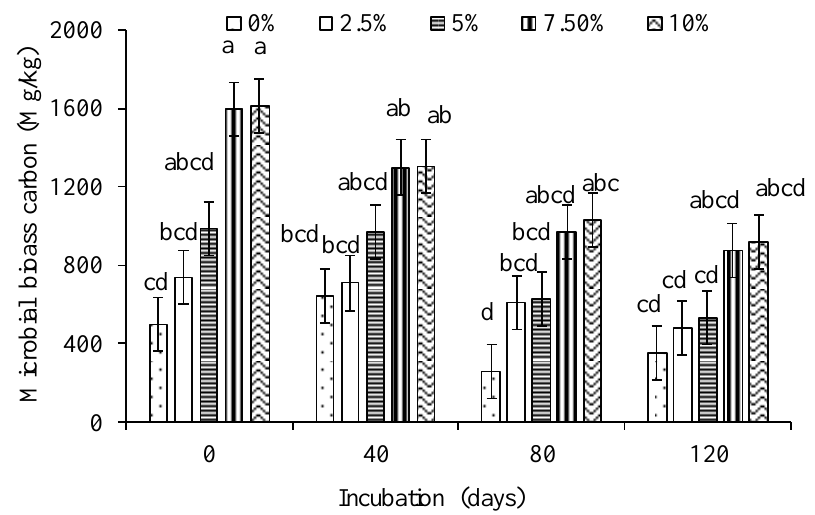
Figure 4. Fluctuations in microbial biomass carbon during incubation of a Hutton soil amended with different biochar rates. Error bars indicate SD. Different lowercase letters indicate significant differences at p ≤